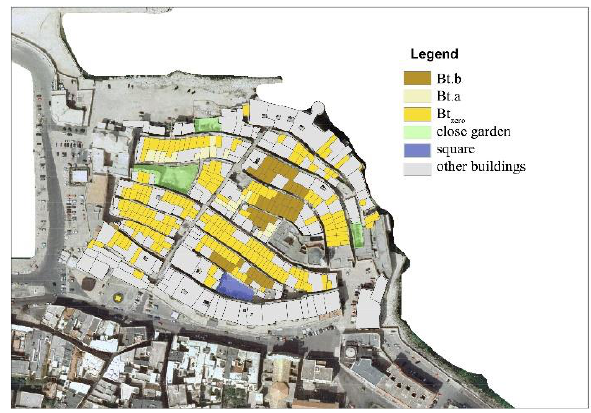
Figure 6. Map of the building type variation referred to states of use and maintenance and map of district transformations.